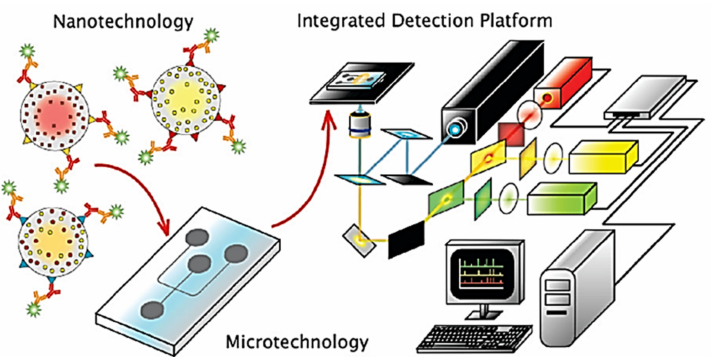
Figure 3. Illustration of the integration of quantum dots, solution-based sandwich assay, microfluidics and fluorescence detection with custom software for high-throughput, multiplexed blood-borne pathogen detection. Reproduced with consent from [33]. Copyright 2007 American Chemical